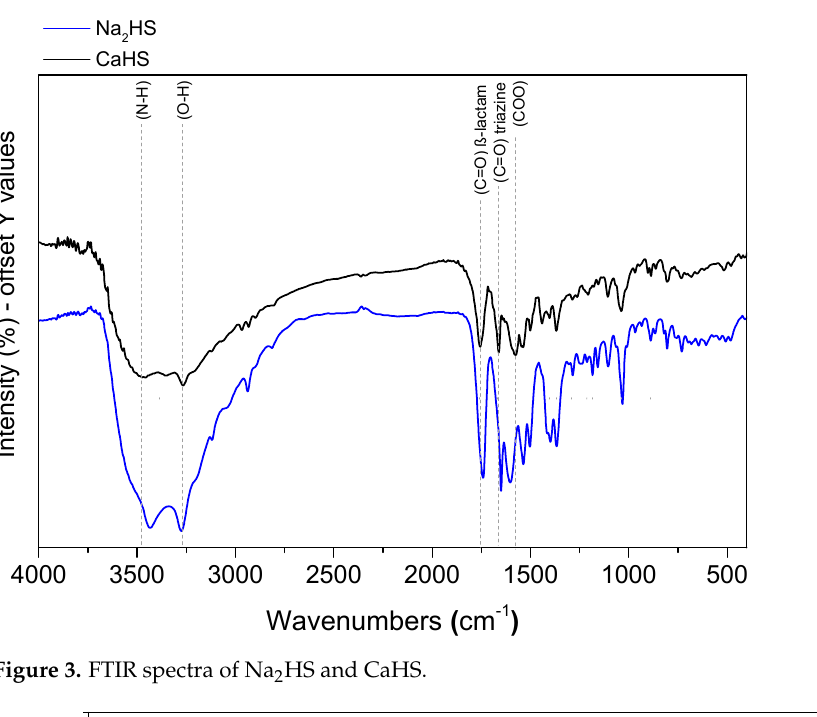
Figure 3 . FTIR spectra of Na 2 HS and CaHS.